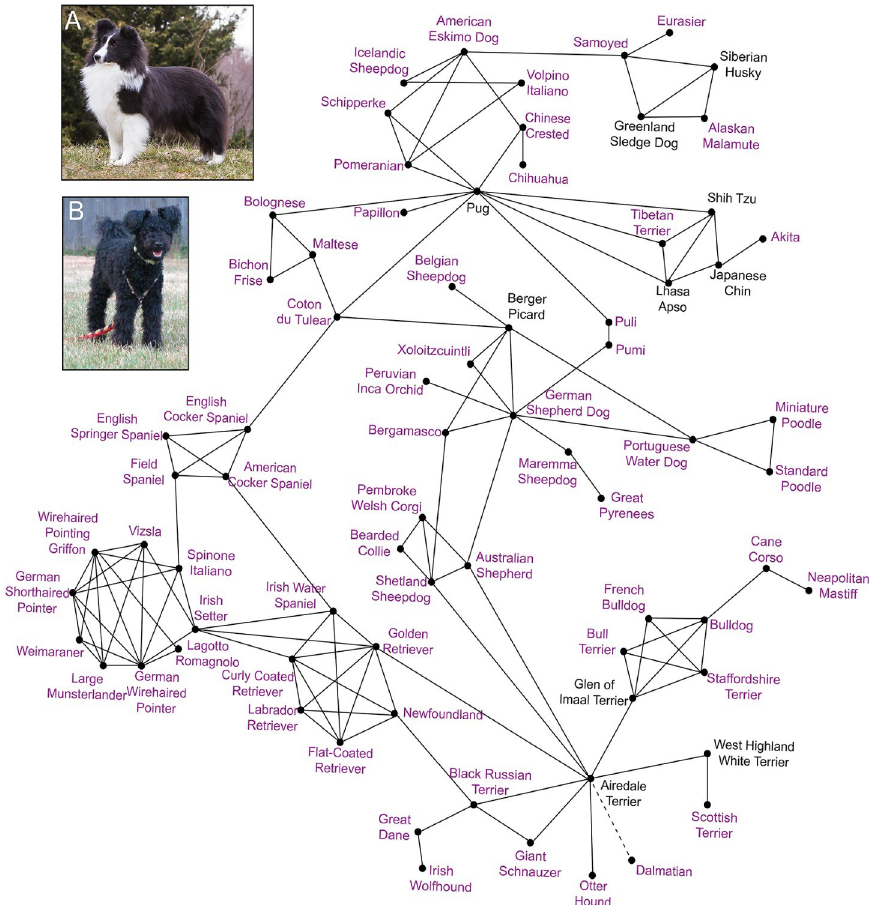
Fig 4. Identity-by-decent (IBD) haplotype sharing breed relationships connect breeds carrying the a allele of ASIP . Solid black lines indicate instances of significant haplotype sharing between breeds. Breed names in purple indicate observed frequency of the a allele within the breed in the present study. Breed names in black indicate that the a allele was not detected within the sampled individuals of that breed. The dashed line connecting the Dalmatian to the Airedale Terrier indicates that no significant haplotype sharing was detected with the Dalmatian, however the highest non-significant level of haplotype sharing was measured with the Airedale Terrier. Inset images show examples of dogs with the recessive black phenotype, A) Shetland Sheepdog, B) Pumi.